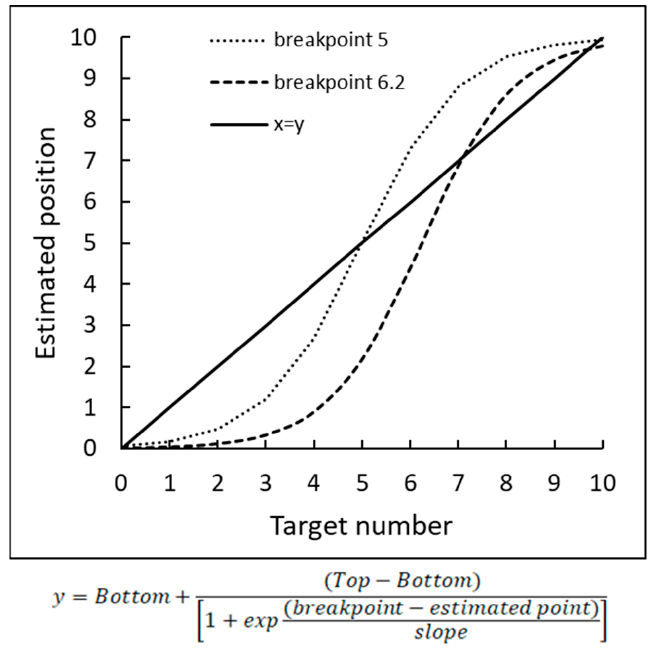
Figure 3. Illustration of number distribution according to the sigmoidal curve function.